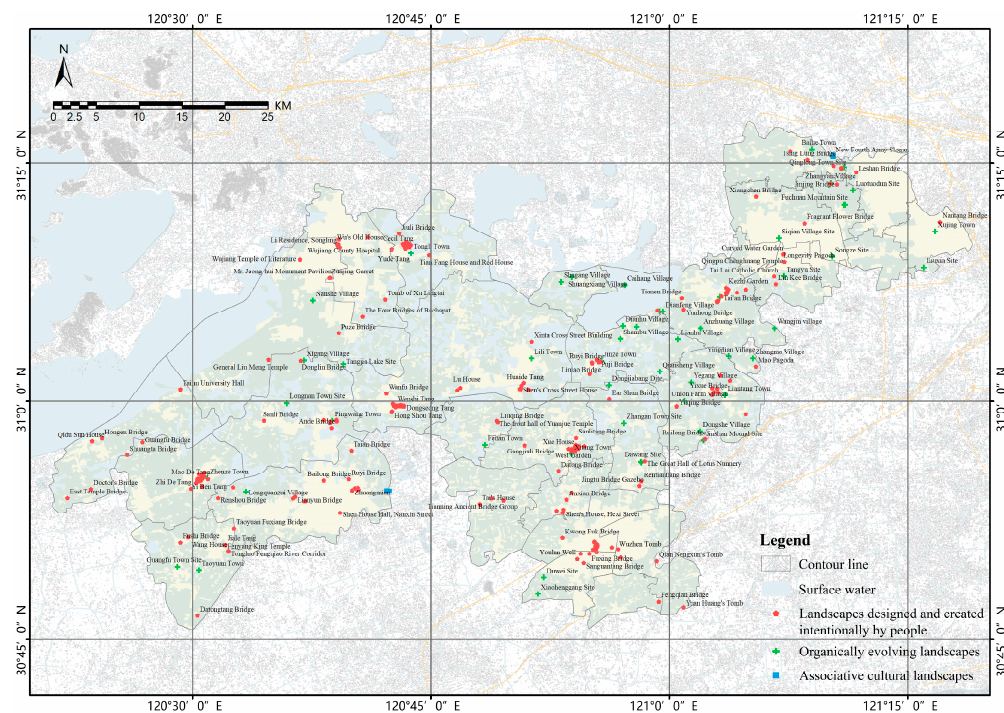
Figure 7. Distribution of value attribute elements in the demonstration area.